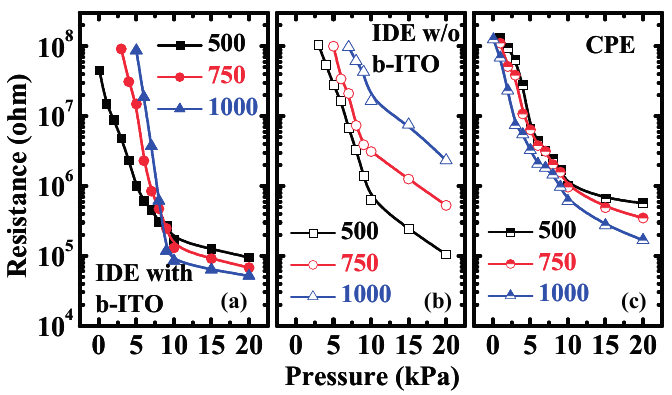
Figure 4. Logarithmic scale of the resistance versus pressure ( R-P) characteristics of the pressure sensors with ( a ) inter-digitated electrode (IDE) with bottom indium-tin-oxide (b-ITO); ( b ) IDE without b-ITO; and ( c ) cross-point electrode (CPE) structures. The characteristics with spin-coating speeds of 500 to 1000 rpm were